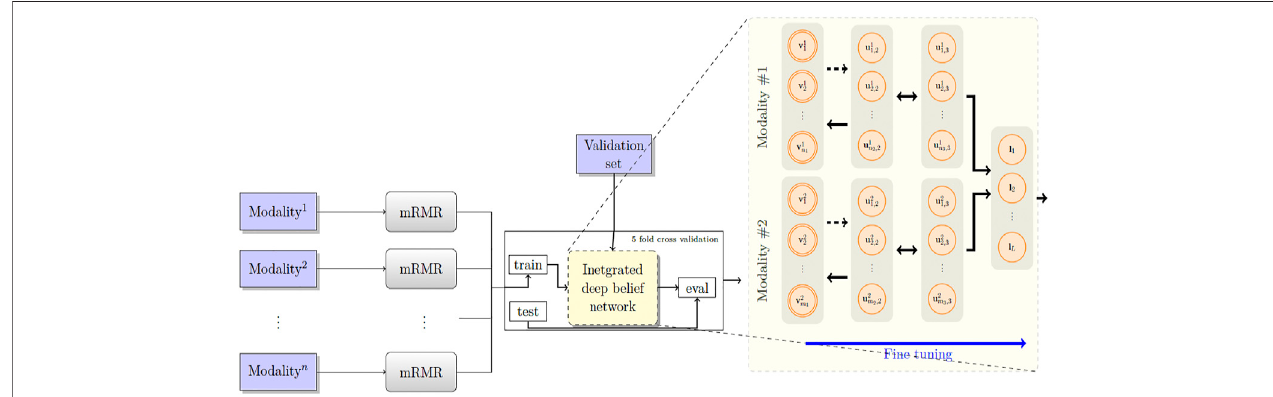
FIGURE 2 | The proposed model RBM. A set of features are fi rst selected for each molecular pro fi le, using mRMR. Then, for each molecular pro fi le, latent features are derived using deep belief nets, which are then fed into a sigmoid layer for downstream